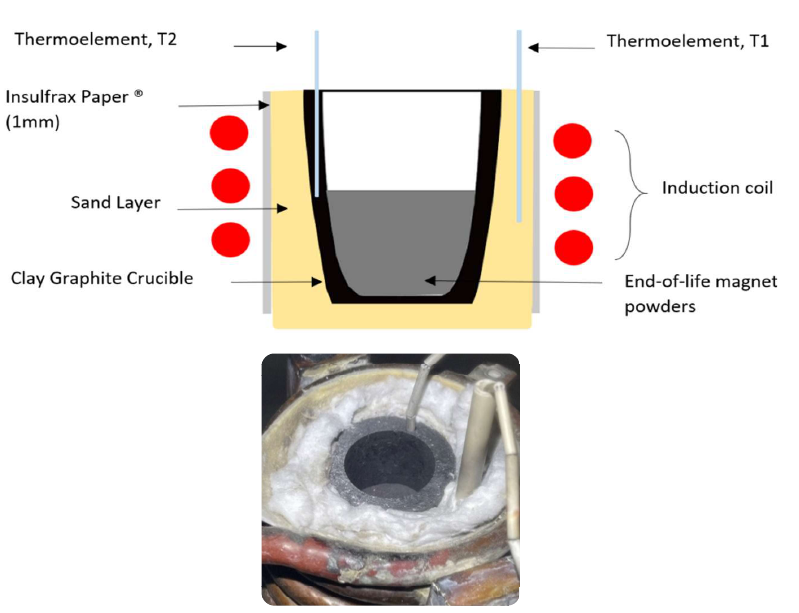
Figure 5. Experimental setup of graphite crucible in an induction furnace